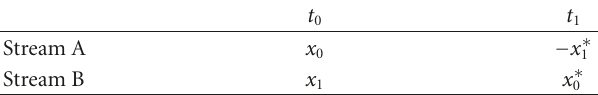
Table 1: Alamouti STBC